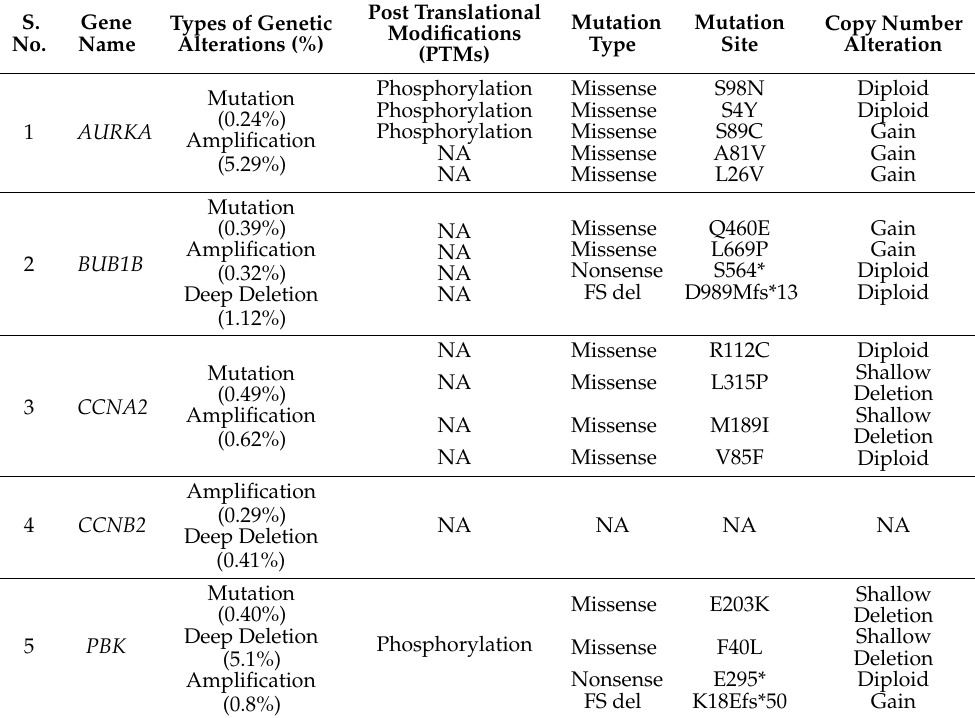
Table 4. Table summarizing the information related to genetic alterations in breast cancer. S. No.